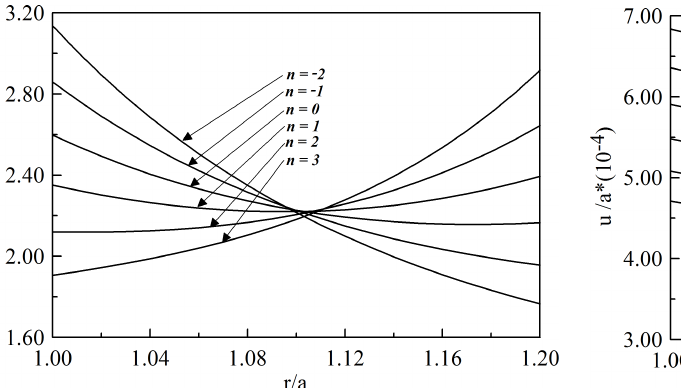
Figure 42: Radially distributed displacement